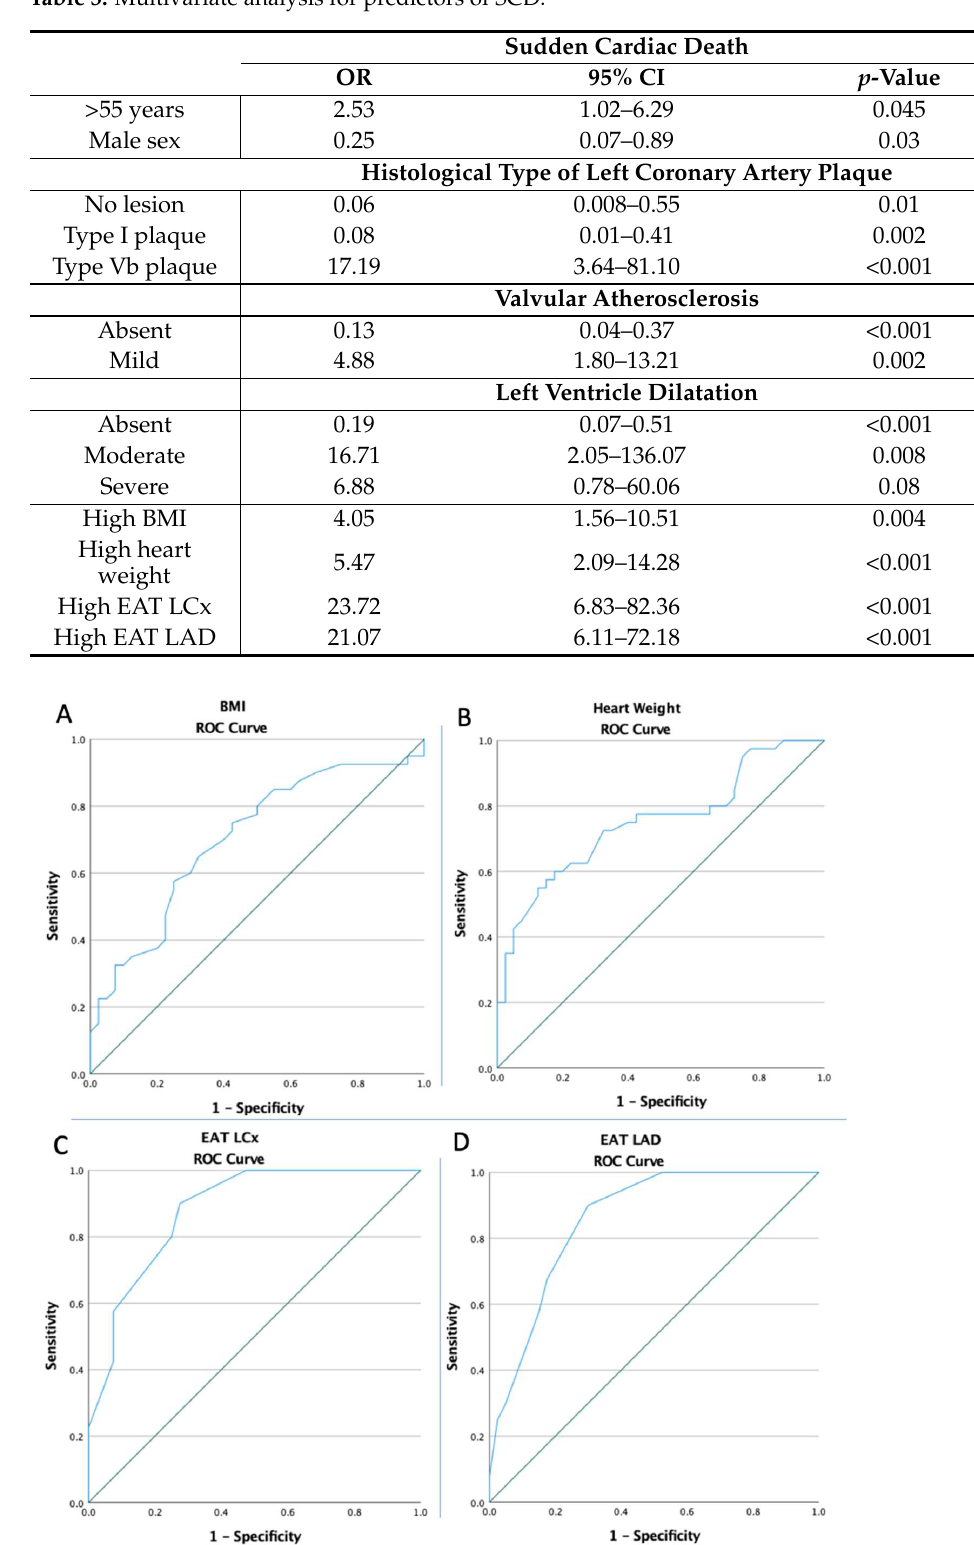
Figure 3. The ROC curve analyses concerning SCD ( A ) for the BMI (AUC: 0.703; p = 0.002), ( B ) for the heart weight (AUC: 0.750; p < 0.0001), ( C ) for the EAT LCx (AUC: 0.881; p < 0.0001), and ( D ) for the EAT LAD (AUC: 0.857; p < 0.0001).